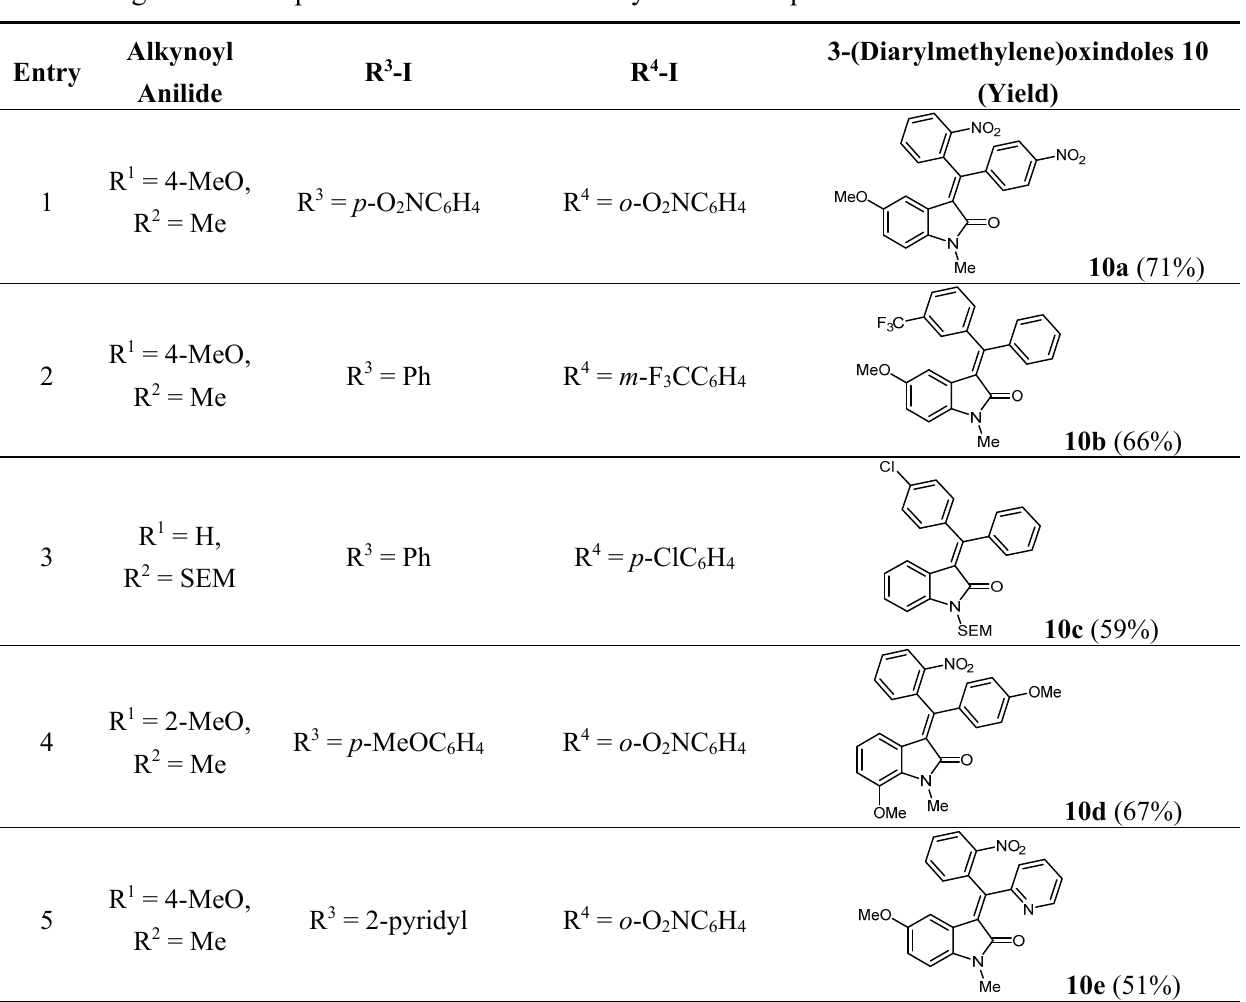
Table 2. Selected 3-(diarylmethylene)oxindoles 10 via sequentially